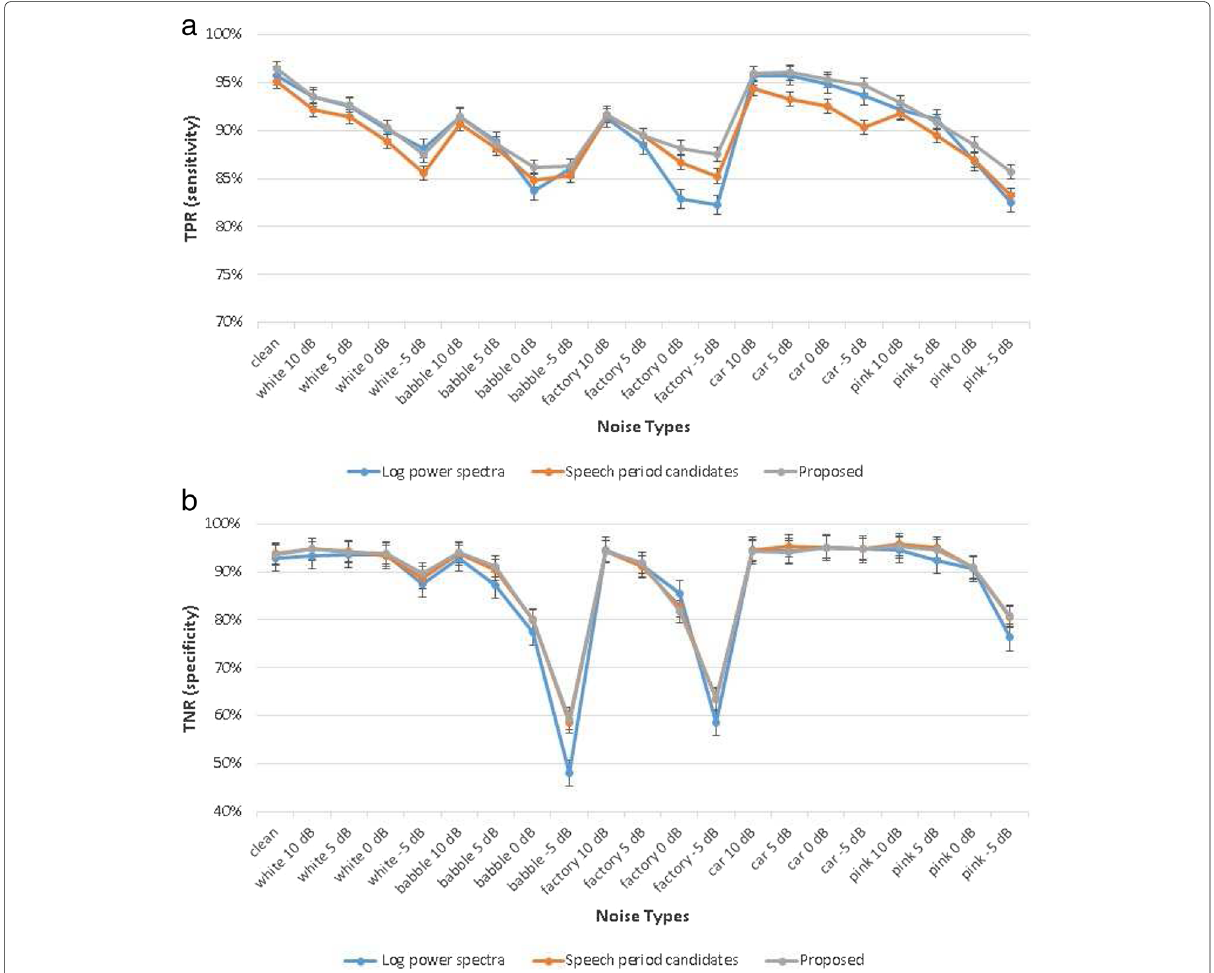
Fig. 9 Sensitivity and specificity comparison between the proposed method and the DNN-based VAD methods using speech period candidates and log power spectra. a TPR (sensitivity). b TNR